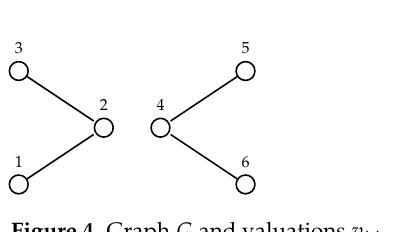
Figure 4. Graph G and valuations v i , j